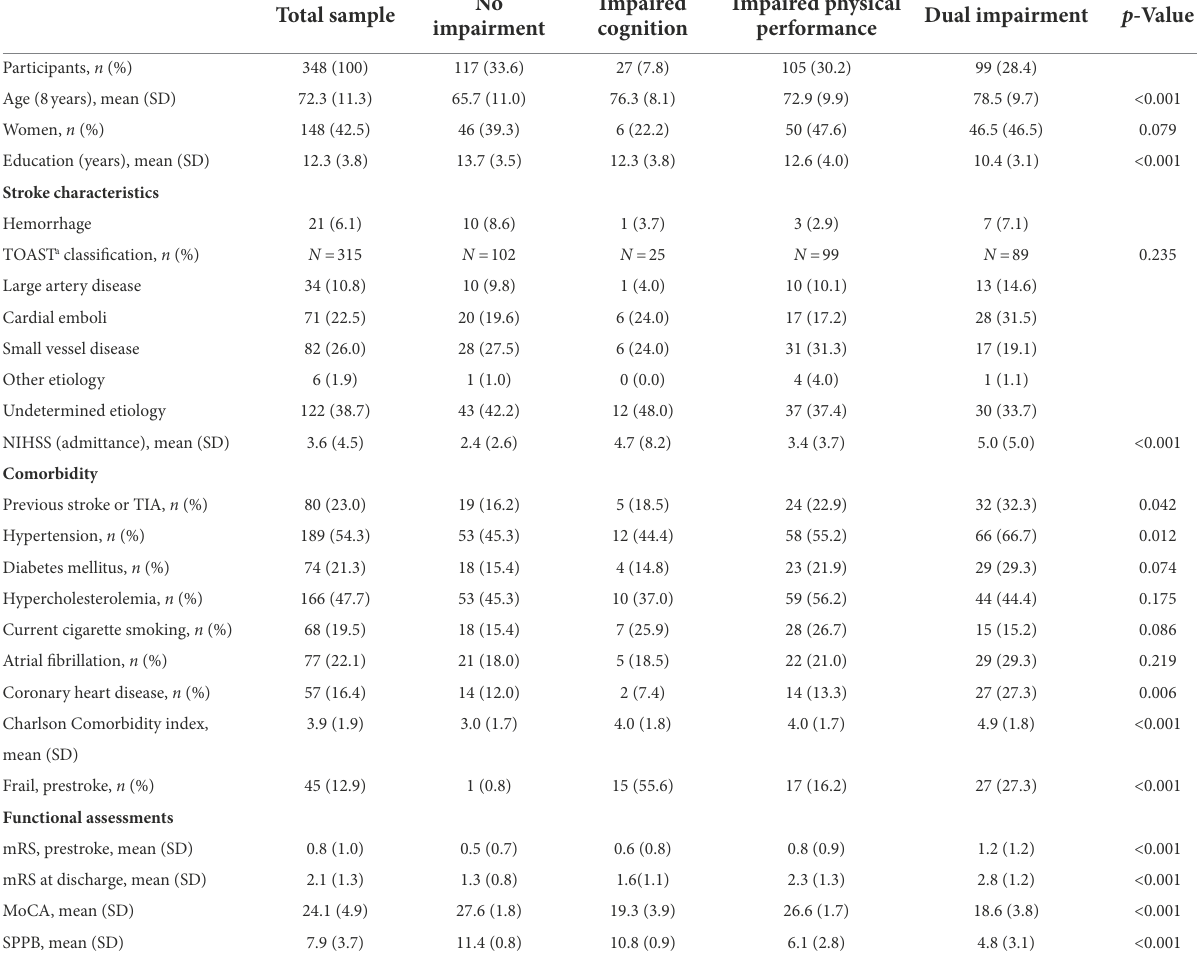
TABLE 2 Baseline